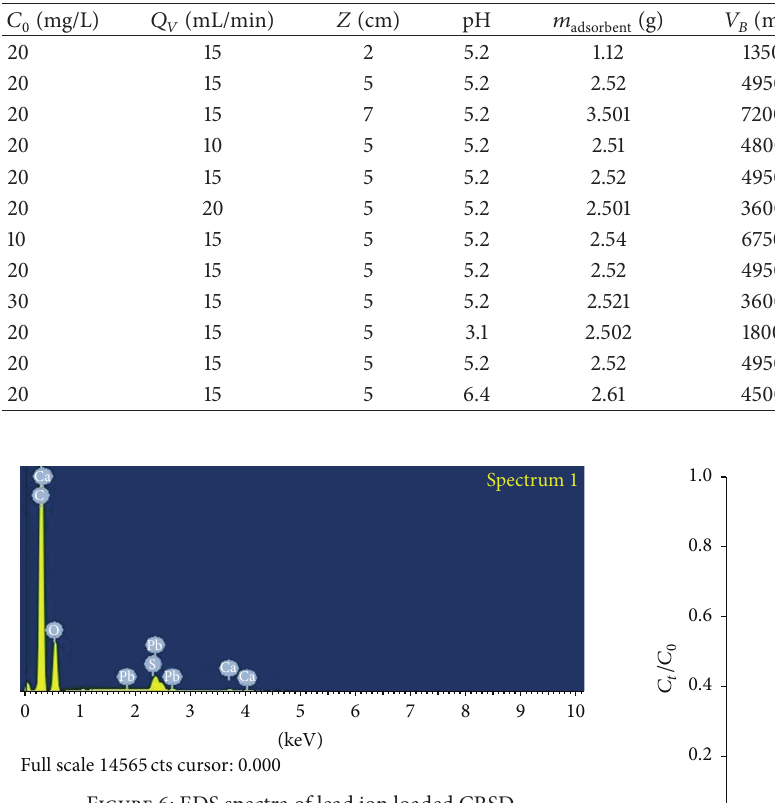
Figure 6: EDS spectra of lead ion loaded CRSD.